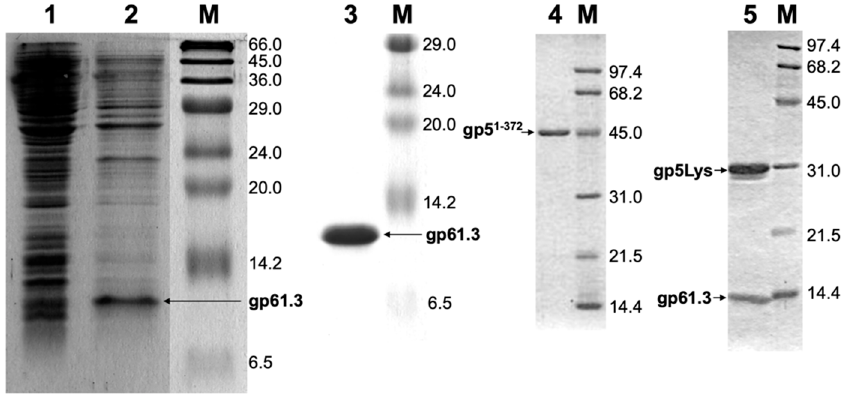
Figure 2. Purification of gp61.3, gp5 1-372 , and the gp61.3-gp5 162-372 (gp61.3-gp5Lys) complex. All panels show Coomassie Blue-stained Sodium dodecyl sulfate polyacrylamide gel electrophoresis (SDS PAGE). Lane 1: the whole cell lysate of cells expressing gp61.3. Lane 2: the supernatant resulting from